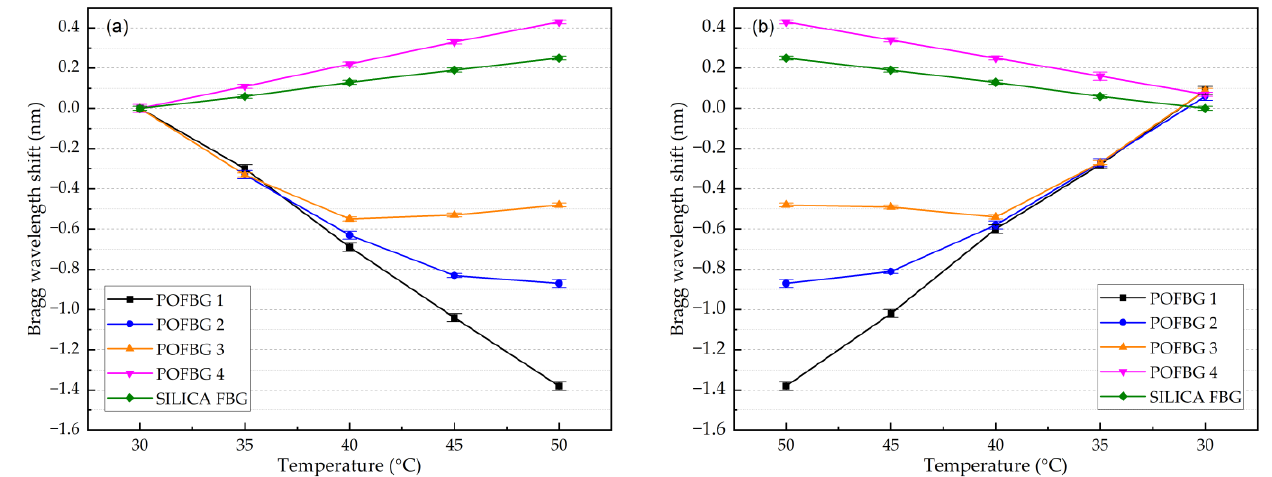
Figure 12. Temperature response of the 4 POFBG array and silica grating sensors under different pre-strain values with ( a ) increasing temperature, and ( b ) decreasing temperature.